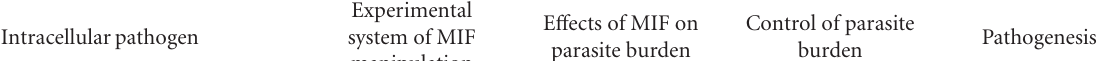
Table 1: Role of MIF in the control of parasite burden and in the pathogenesis of protozoan infections. Intracellular